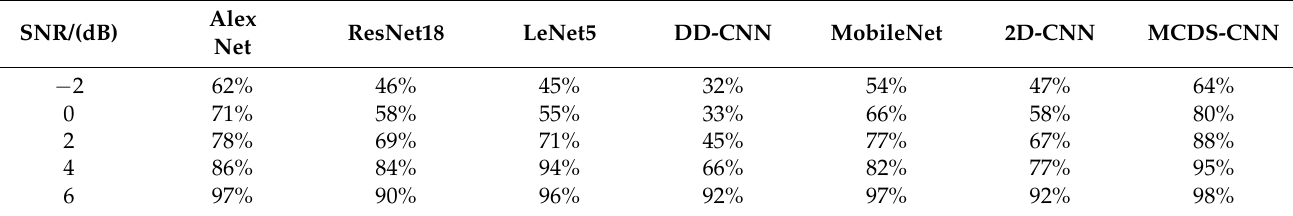
Table 14. Accuracy of the proposed model MCDS-CNN, and other six models on data set 2.